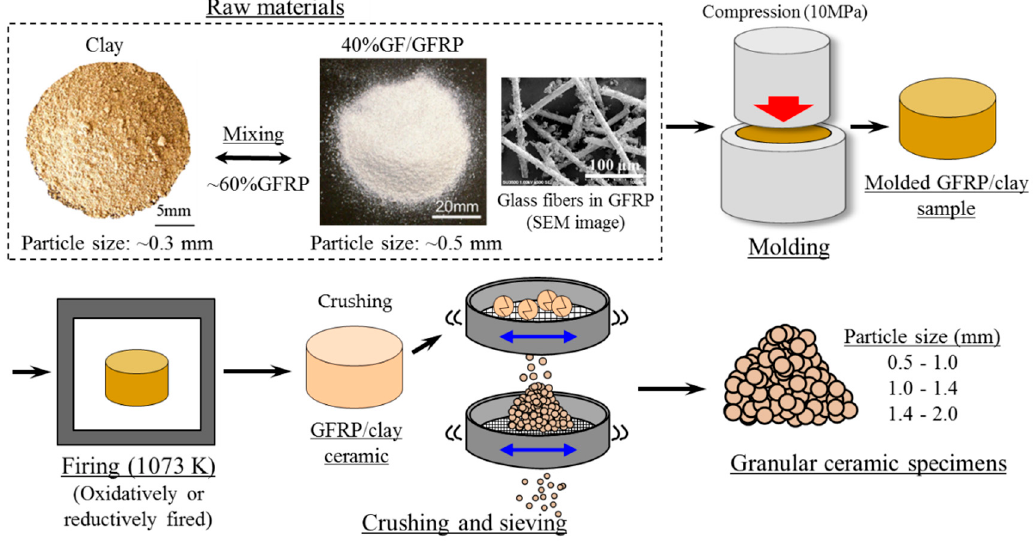
Figure 1. The manufacturing process of granular GFRP/clay ceramics for MB dye adsorption testing. Table 1. Compositions of inorganic substances in the clay and GFRP.